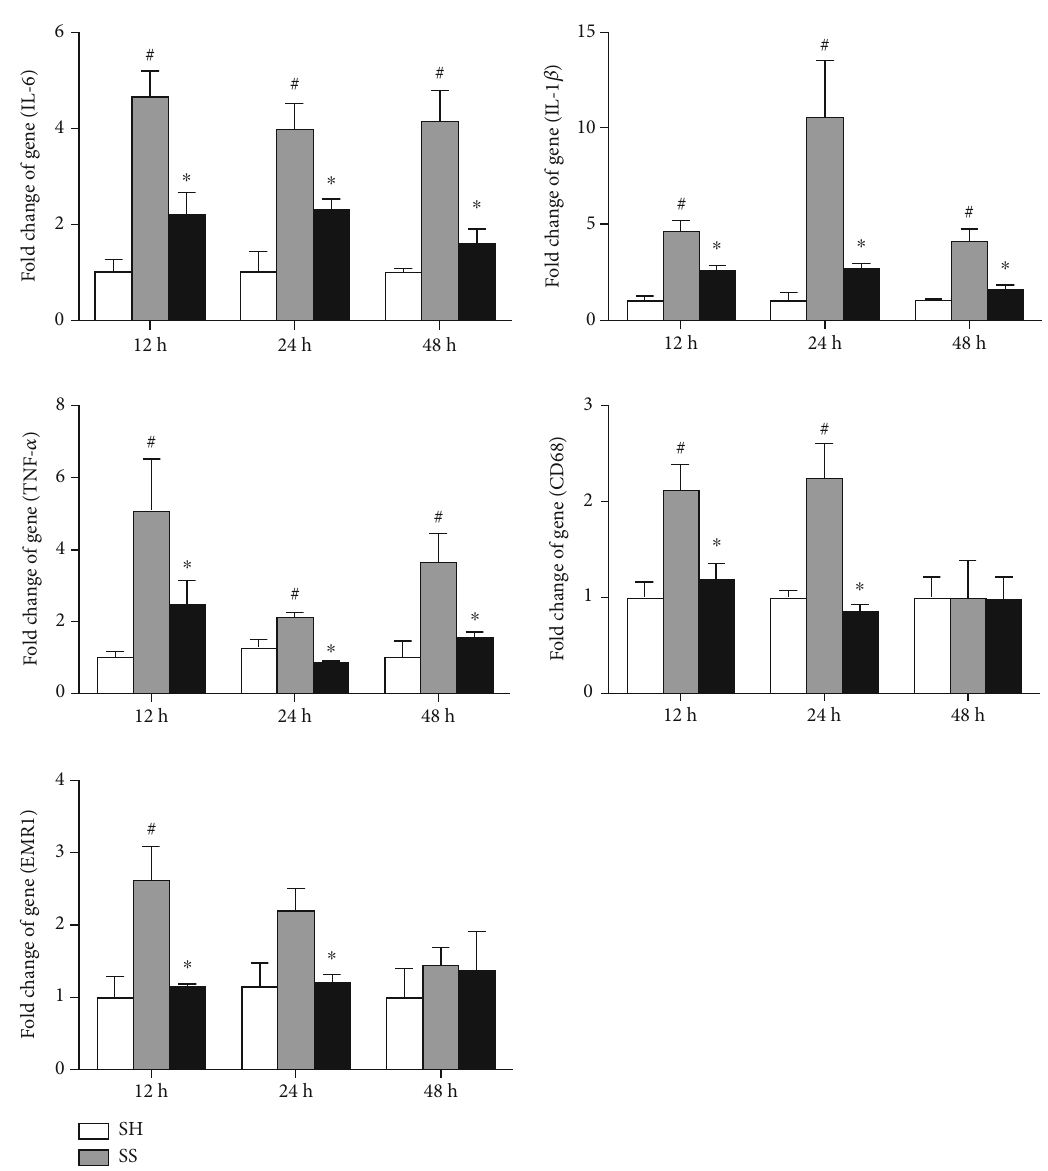
Figure 5: Messenger (m)RNA expressions of in fl ammatory cytokines and macrophage in fi ltration markers in epididymal fat tissues. IL-1 β : interleukin-1 β ; IL-6: interleukin-6; TNF- α : tumor necrosis factor- α ; cluster of di ff erentiation (CD) 68; epidermal growth factor-like module- containing mucin-like hormone receptor-like 1 (EMR-1). SH: sham-operated group; SS: sepsis group with saline; SG: sepsis group with glutamine. mRNA changes were quantitated and analyzed by a real-time PCR and were calculated by the comparative CT (2 - ΔΔ Ct ) method. mRNA expression levels in the normal control group were used as a calibrator. Values are expressed as the mean ± SEM . n = 8 for each group at 12, 24, and 48 h after cecal ligation and puncture (CLP). Di ff erences among groups at each time point were analyzed by a one-way ANOVA followed by Tukey ’ s post-hoc test. The symbol # signi fi cantly di ff ers from the SH group; the symbol “ ∗ ” signi fi cantly di ff ers from the SS group ( p < 0 : 05